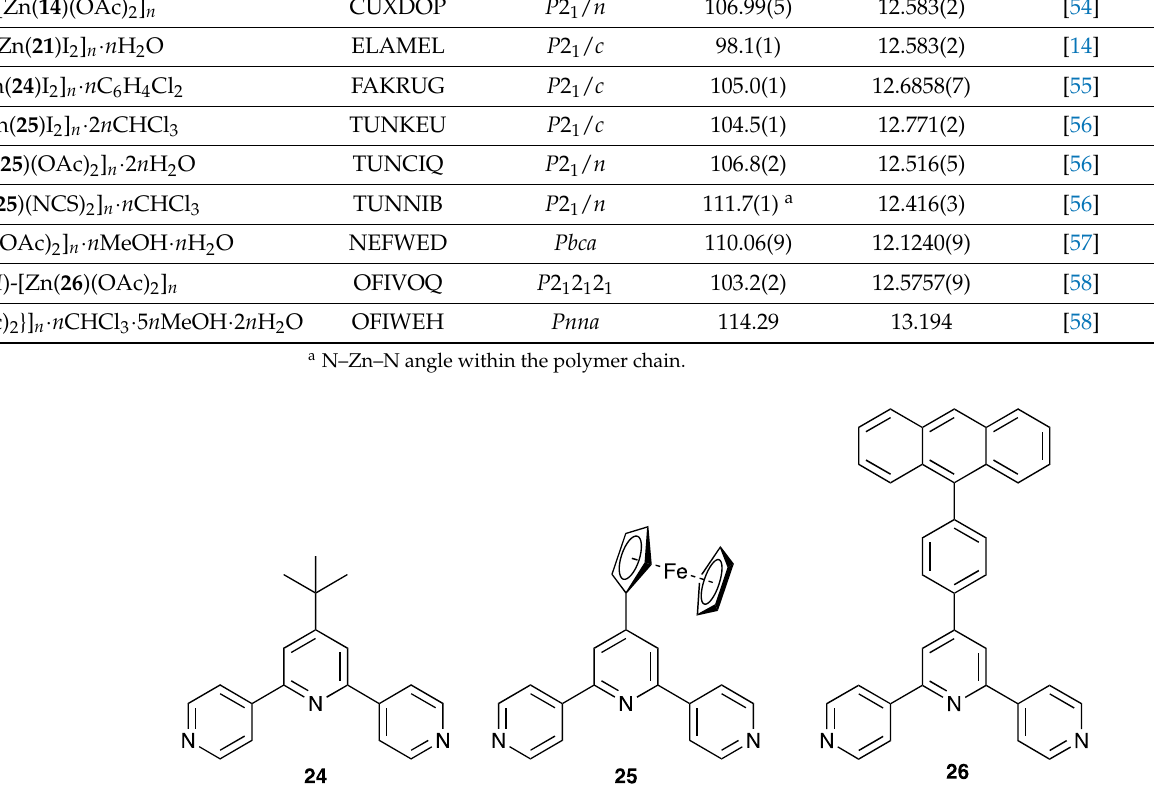
Table 2. 1D ‐ coordination polymers of general formula [Zn(4’ ‐ X ‐ 4,2’:6’,4” ‐ tpy)X 2 ] n with X – = I – , AcO – , NCS – . Table 2. 1D-coordination polymers of general formula [Zn(4 (cid:48) -X-4,2 (cid:48) :6 (cid:48) ,4 (cid:48)(cid:48) -tpy)X 2 ] n with X – = I – , AcO – , NCS – . Compound Compound CSD Refcode Space Group N–Zn–N/ ◦ Ref.